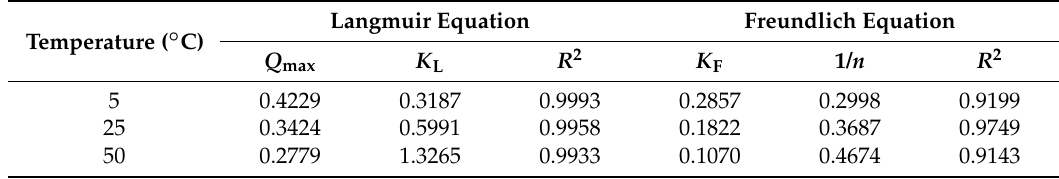
Table 2. Langmuir and Freundlich parameters of aucubin on HPD850 resin at 5, 25 and 50 °C.